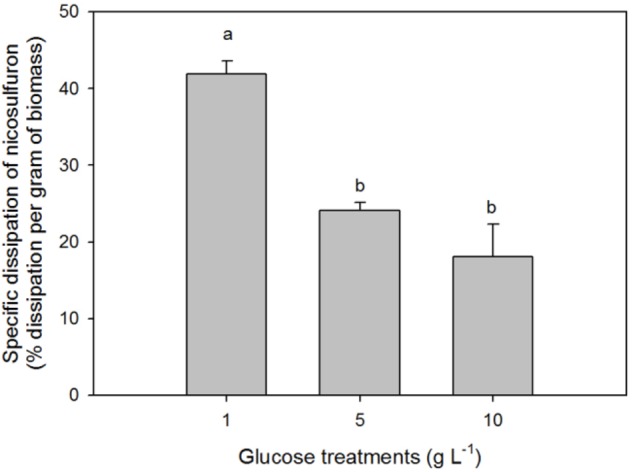
Specific biodegradation percentage of 100 μM nicosulfuron by P. cucumerina AR1 in the presence of various glucose concentrations. Values are expressed as the mean ± standard error (SE), n = 3. Differences between treatments are marked by letters a > b (Tukey’s test, P < 0.05).